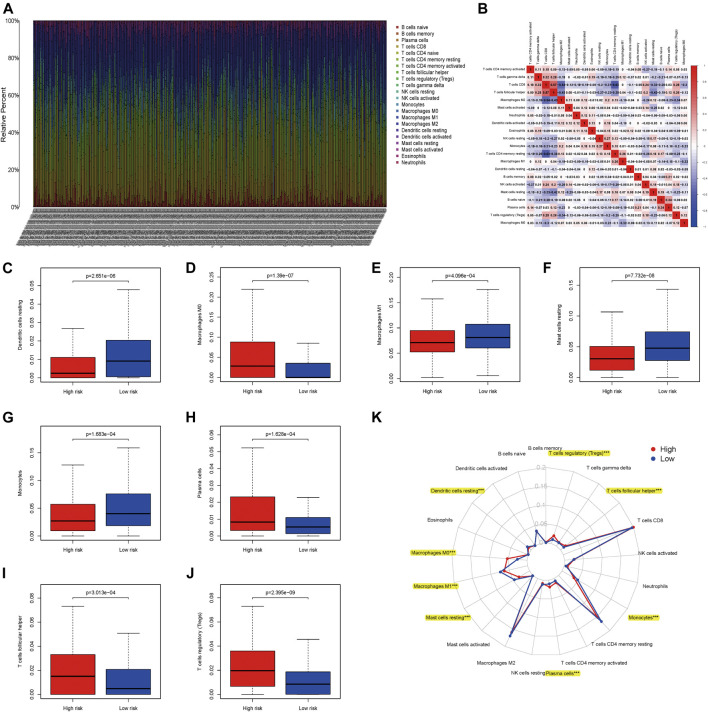
Associations between apoptosis-related genes signature and tumor-infiltrating immune cells (TIICs) in ccRCC; (A) The expression of TIICs of all ccRCC samples. (B) Correlation matrix of all TIICs proportions; (C) Dendritic cells resting between high- and low-risk patients with ccRCC; (D) Macrophages M0 between high- and low-risk patients with ccRCC; (E) Macrophages M1 between high- and low-risk patients with ccRCC; (F) Mast cells resting between high- and low-risk patients with ccRCC; (G) Monocytes between high- and low-risk patients with ccRCC; (H) Plasma cells between high- and low-risk patients with ccRCC; (I) T cells follicular helper between high- and low-risk patients with ccRCC; (J) T cells regulatory (Tregs) between high- and low-risk patients with ccRCC; (K) The difference of immune cell infiltration abundances in ccRCC subtypes.